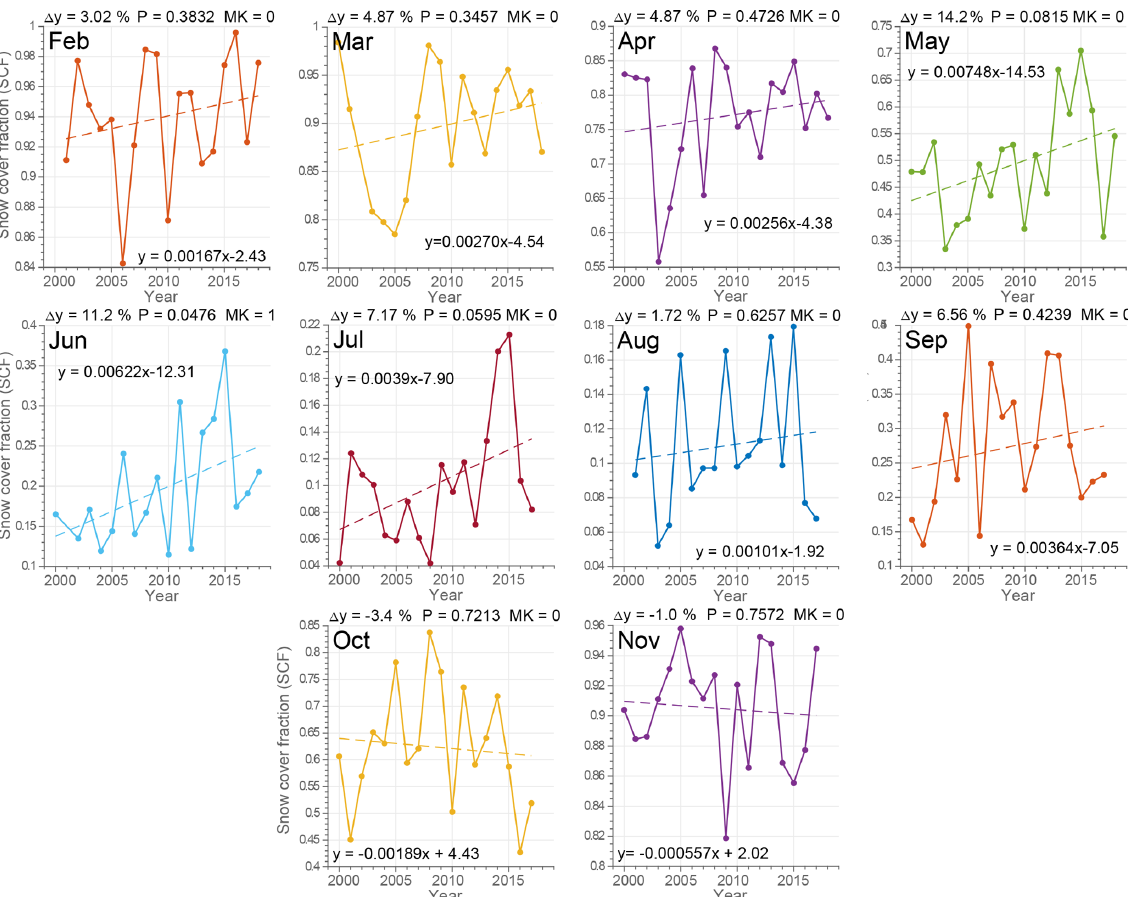
Figure 12. Monthly mean results for snow cover. For each month mean snow cover extent is calculated and a linear fit applied. The results from the Mann–Kendall test are shown as 1 or 0, where 1 indicates a significant change in trend. A linear equation shows the results for a fitted linear model to the data set. (cid:49)y is a non-statistical parameter and shows the average linear slope of the